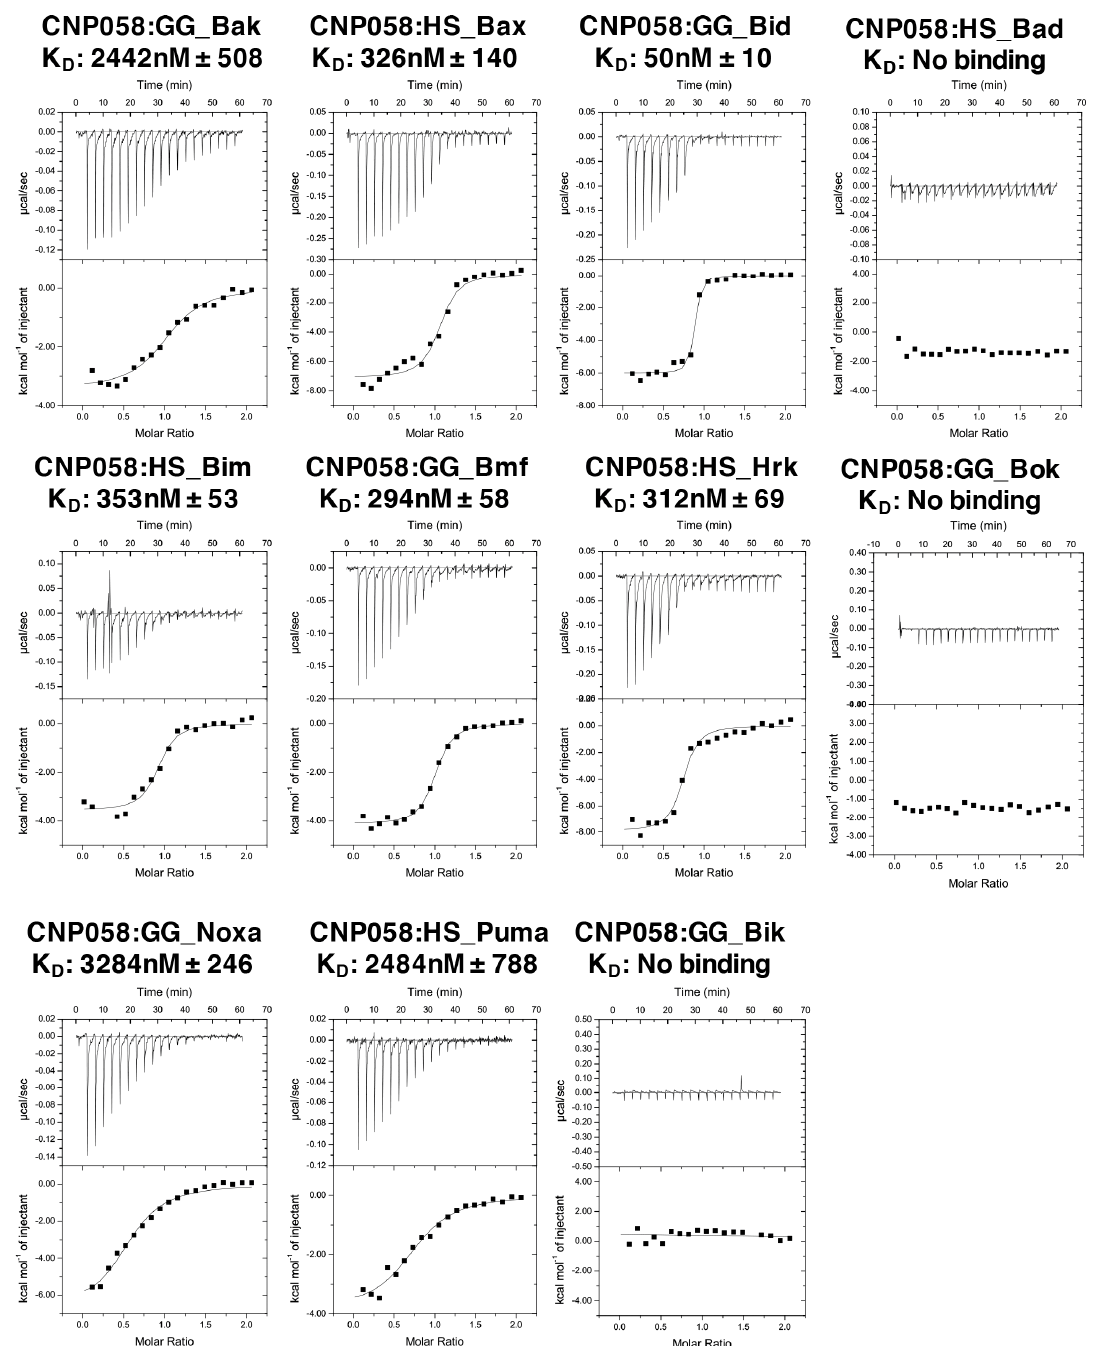
Figure 2. CNP058 interacts with Bak and Bax as well as all BH3-only proteins except Bad and Bik. Raw heats measured by isothermal titration calorimetry (ITC) for CNP058 interactions with Bcl-2 homology domain 3 (BH3) domain peptides of pro-death B-cell lymphoma 2 (Bcl-2) proteins from Homo sapiens (HS) and Gallus gallus (GG).